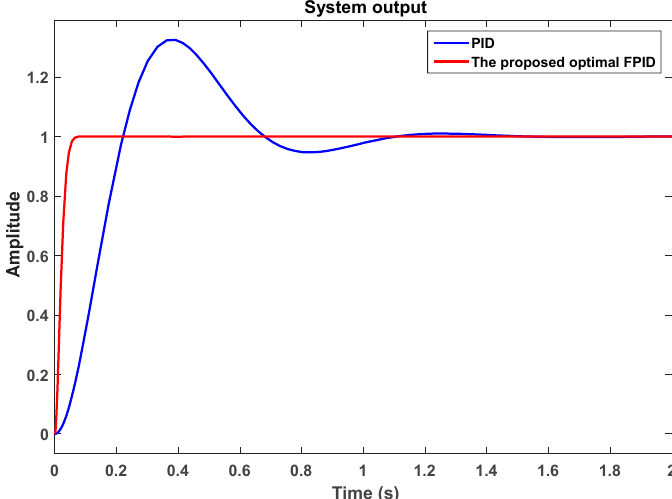
Figure 8. Performance of GAs across generations: ( a ) with initial equivalent FLC; and ( b ) without initial equivalent FLC.